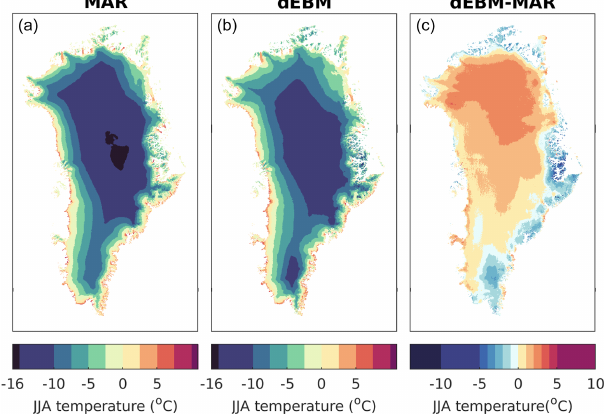
Figure 8. Comparison of multi-year (1980–1999) mean sum- mer near-surface temperature from experiments MAR ERA (a) and dEBM MAR , ERA (b) and differences between dEBM MAR , ERA and MAR ERA (c) .